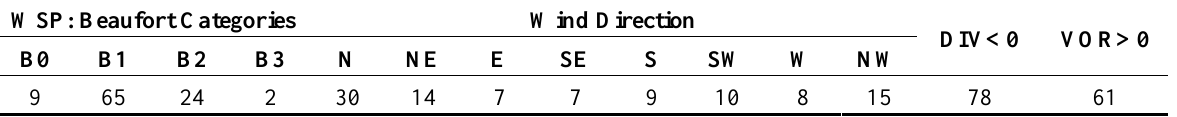
Table 7. Percentages (%) of the wind events for each discrete value of the wind parameters. WSP: Beaufort Categories Wind Direction